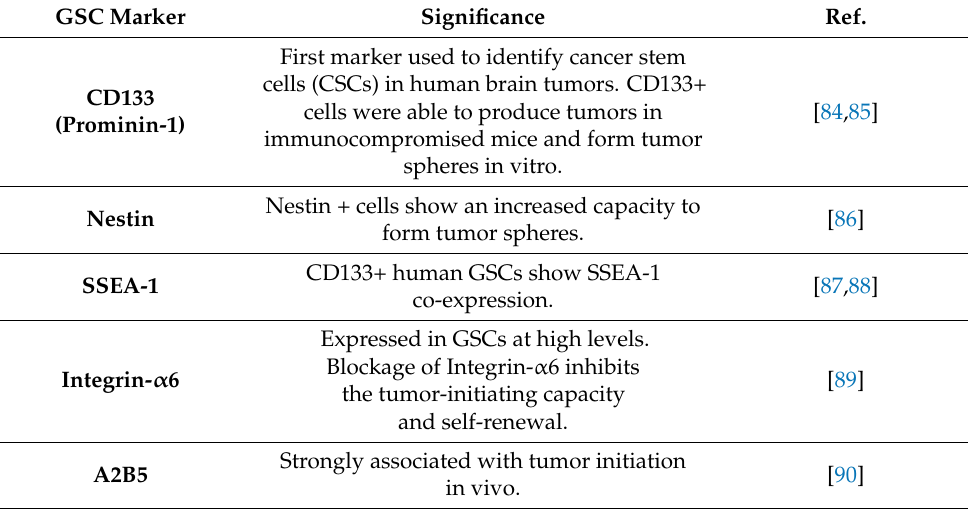
Table 2. Markers of glioma stem